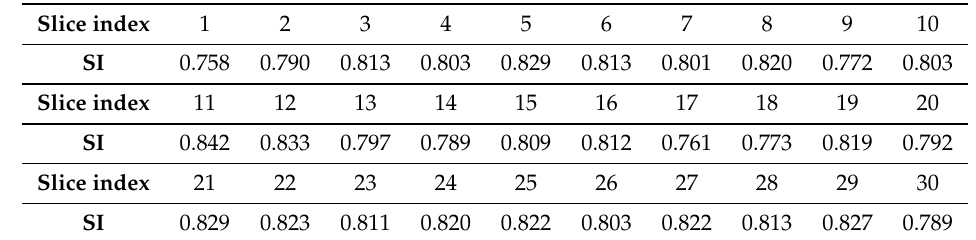
Table 1. Similarity index obtained on several different samples of brain tumor from the dataset in Reference [65].